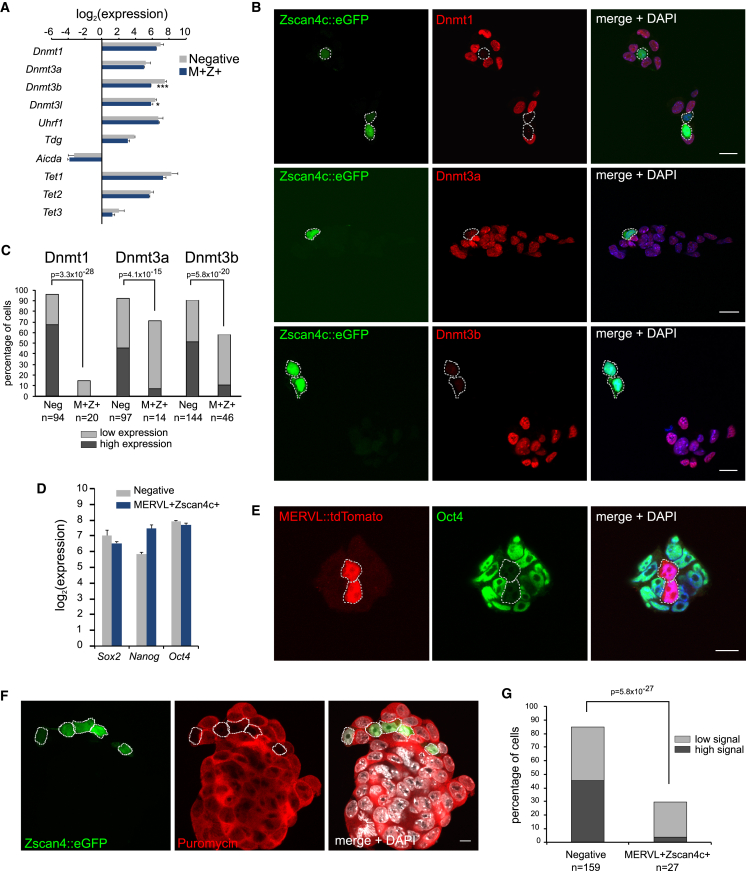
Translation Block Leads to Depletion of Dnmt Enzymes(A) Expression levels of DNA methylation machinery transcripts between negative-sorted (gray) and MERVL+Zscan4c+ (M+Z+, dark blue) cells as determined by RNA-sequencing. Bars represent mean + SD of at least three biological replicates. ∗p < 0.05, ∗∗∗p < 0.0001, homoscedastic two-tailed t test.(B) Representative single z-slices of cells labeled by Zscan4c::EGFP reporter (green) immunostained for Dnmt1 (top row, red), Dnmt3a (middle row, red), or Dnmt3b (bottom row, red). Blue depicts DAPI staining. Zscan4c+ cells are outlined in white dotted lines. Scale bar represents 25 μm.(C) Semiquantitative analysis of immunofluorescence staining of protein levels. Cells were scored as having high (dark), low (light), or no expression of Dnmt1, Dnmt3a, or Dnmt3b. Cells were subsequently scored using either the Zscan4c::EGFP or MERVL::tdTomato reporters as negative or MERVL+Zscan4c+ (M+Z+) cells. Differences are statistically significant (chi-square test).(D) Expression levels of Sox2, Nanog and Oct4 pluripotency transcripts between negative sorted (gray) and MERVL+Zscan4c+ (dark blue) cells as determined by RNA-sequencing. Bars represent mean + SD of at least three biological replicates.(E) Oct4 immunofluorescence staining of cells labeled by the MERVL::tdTomato reporter (middle panel, red). MERVL+ cells are outlined in white dotted lines. Scale bar represents 10 μm.(F) SUnSET assay showing sites of active translation by a puromycin pulse and detected using a puromycin antibody (second panel, red) in cells labeled with the Zscan4c::EGFP reporter (first panel, green). DNA is visualized with DAPI (gray). Zscan4c+ cells are outlined in white dotted lines. Scale bar represents 10 μm.(G) Semiquantitative analysis of SUnSET assay. Percentage of cells scored as having high (dark gray) or low (light gray) levels of puromycin immunofluorescence. Subsequently, cells were scored based on either the Zscan4c::EGFP or MERVL::tdTomato as negative cells or MERVL+Zscan4c+ cells.See also Figure S5.